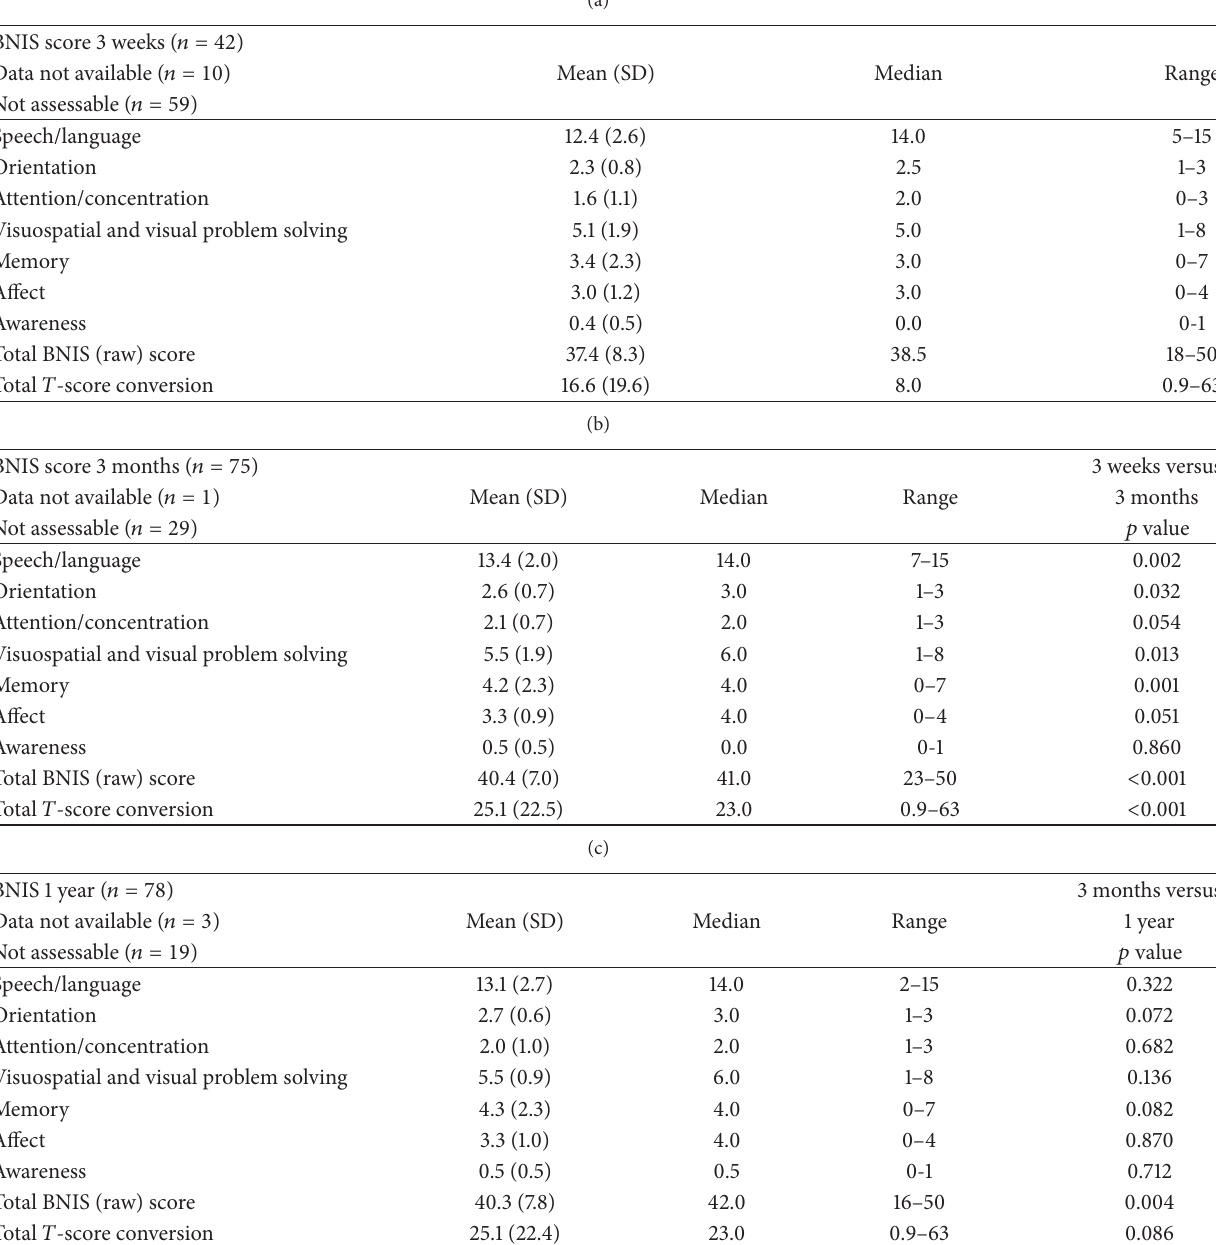
Table 4: BNIS subscales scores, BNIS total score, and 𝑇 -score conversion at 3 weeks, 3 months, and 1 year.